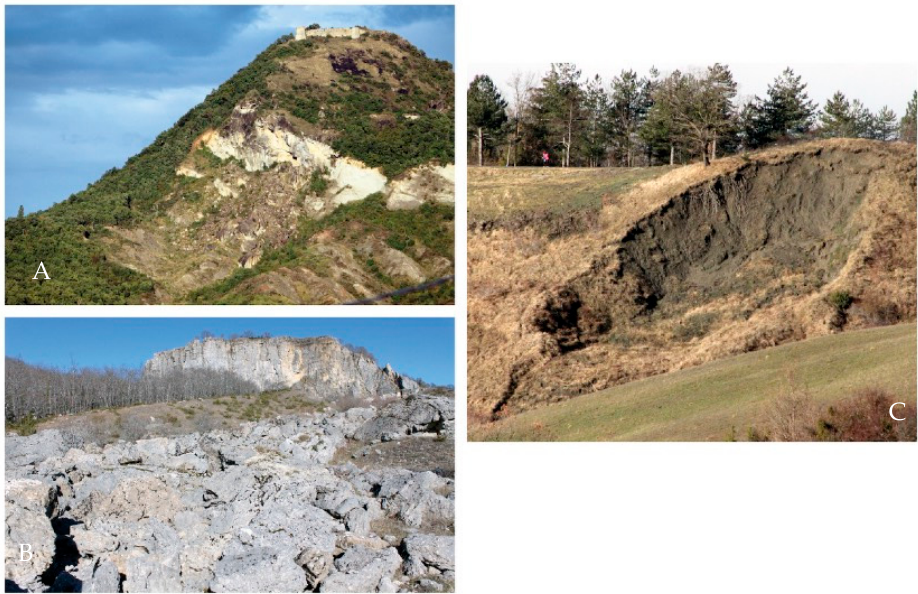
Figure 6. Landslides of Paesaggeo online survey: ( A ) active rock-fall of Maiolo; ( B ) moving boulders of Sasso Simone; ( C ) small landslide with a tree.